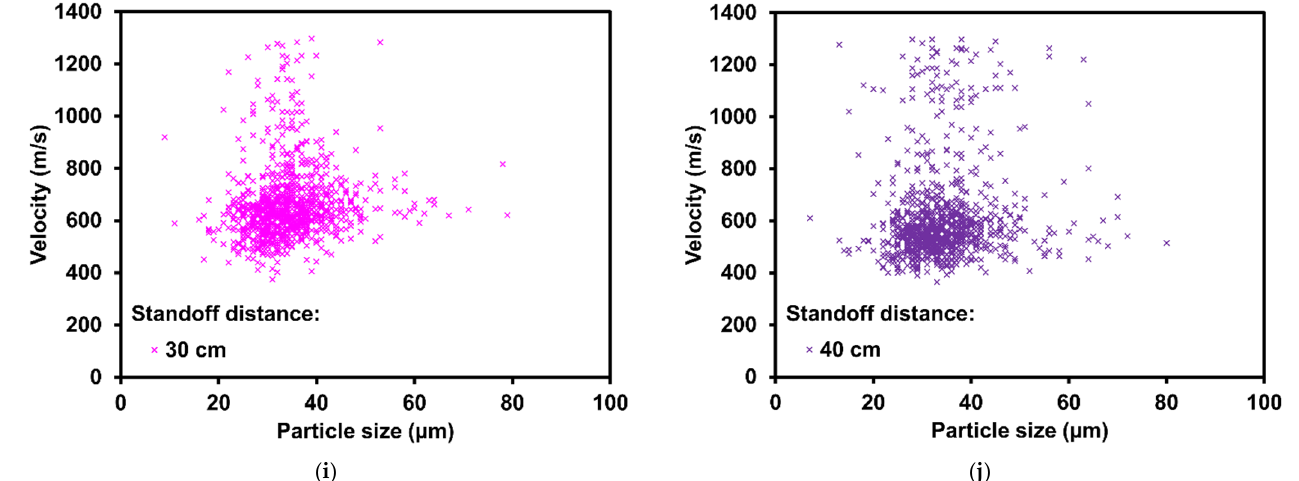
Figure 2. ( a ) Velocity measurement and simulation results for Inconel 625 at different spray distances. ( b ) Individual particle velocity corresponding to the particle size and spray distance in 3D graphical format and in 2D graphical format for ( c ) 3 cm, ( d ) 6 cm, ( e ) 8 cm, ( f ) 10 cm, ( g ) 12 cm, ( h ) 20 cm, ( i ) 30 cm, and ( j ) 40 cm spray distances.